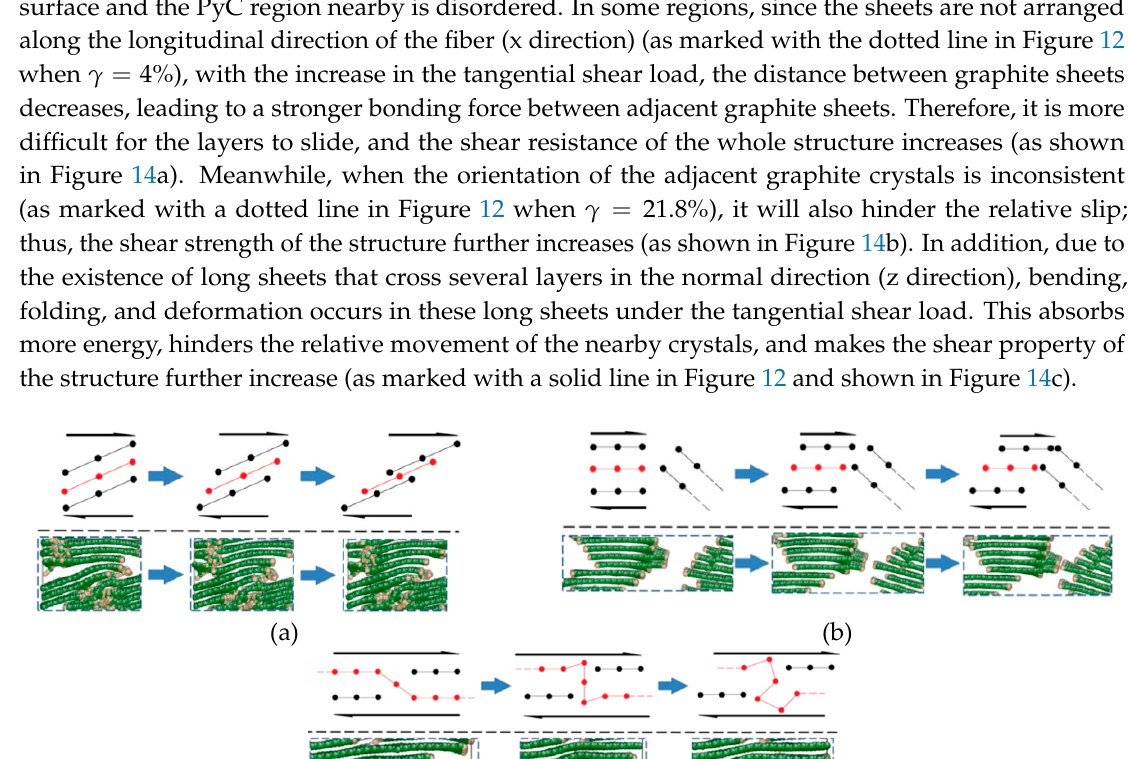
Figure 14. The main mechanism of the C f /PyC interphase to improve the shear mechanical L is smaller: ( a ) non-in-plane shear behavior; ( b ) the barrier between crystals; ( c ) properties when a long sheet folding.